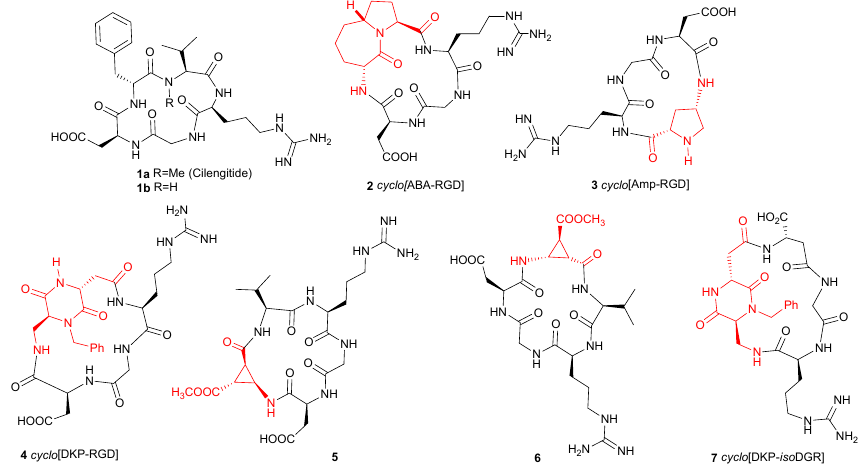
Figure 1. Cyclic RGD and iso DGR integrin ligands (azabicyclic alkane (ABA), aminoproline (Amp), and diketopiperazine scaffolds (DKP)).